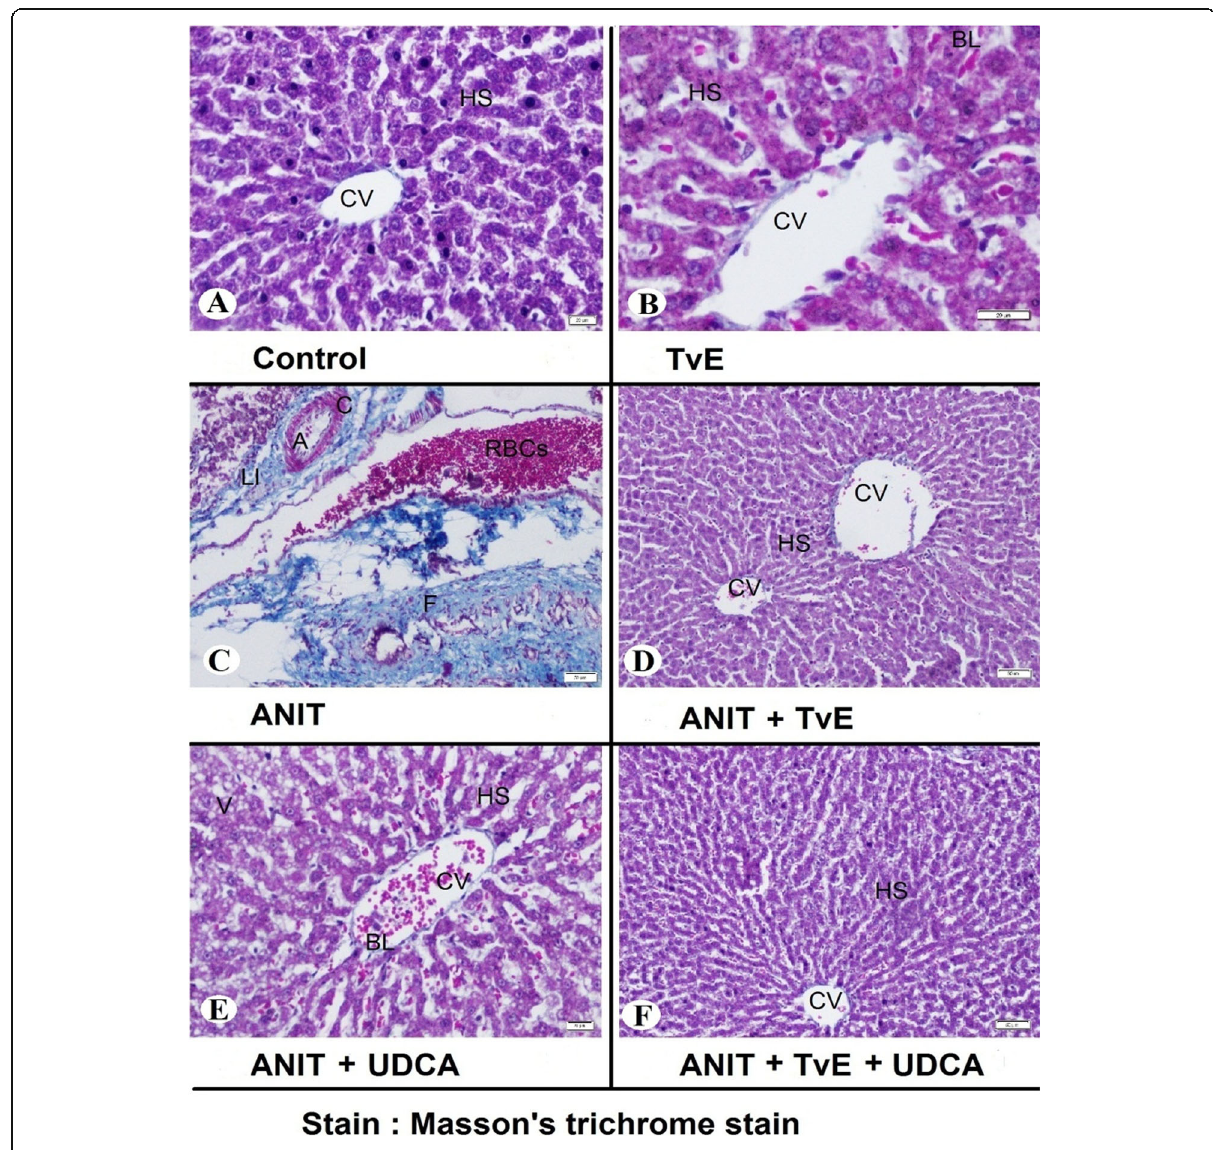
Fig. 3 Photomicrographs of liver tissues for fibrosis evaluation in all rat groups, stained with Masson's trichrome stain. a Control group showing the normal architecture of the liver, with hepatic strands (HS) around the central vein (CV) (scale bar 20 μ m). b (TvE) group showing the normal architecture of the liver, with hepatic strands (HS) around the central vein (CV) (scale bar 20 μ m). c ANIT group showing severe fibrosis (F) around hepatic vein and hepatic artery (A), congestion (C) in hepatic vein and leukocytes infiltration (LI) (scale bar = 50 μ m). d ANIT + TvE group showing the normal architecture of the liver, with hepatic strands (HS) around the central vein (CV) (scale bar = 50 μ m). e ANIT + UDCA group showing normal hepatic strands (HS) around the central vein (CV) and mild bleeding (scale bar = 20 μ m). f ANIT + AIE + UDCA group showing the normal architecture of the liver, with hepatic lobules around the central vein (CV) and each lobule consisting of hepatic strands (HS) of hepatocytes (scale bar 50 μ